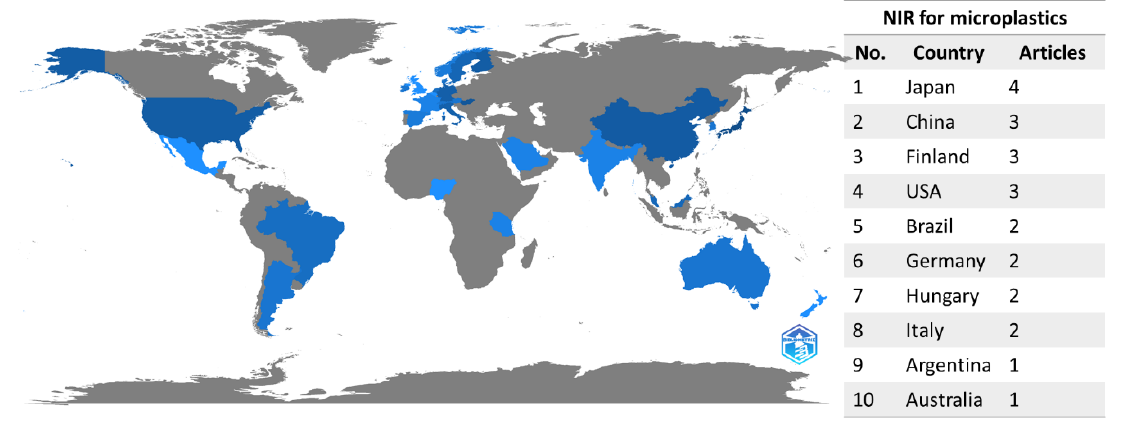
Figure 4. Scientific production by country-NIR related Literature. The map was using the open-source tool Biblioshiny for Bibliometrix [38]. Different shades of blue indicate different productivity rate: dark blue = high productivity; grey = no articles. Number of documents is listed per corresponding author’s countries.